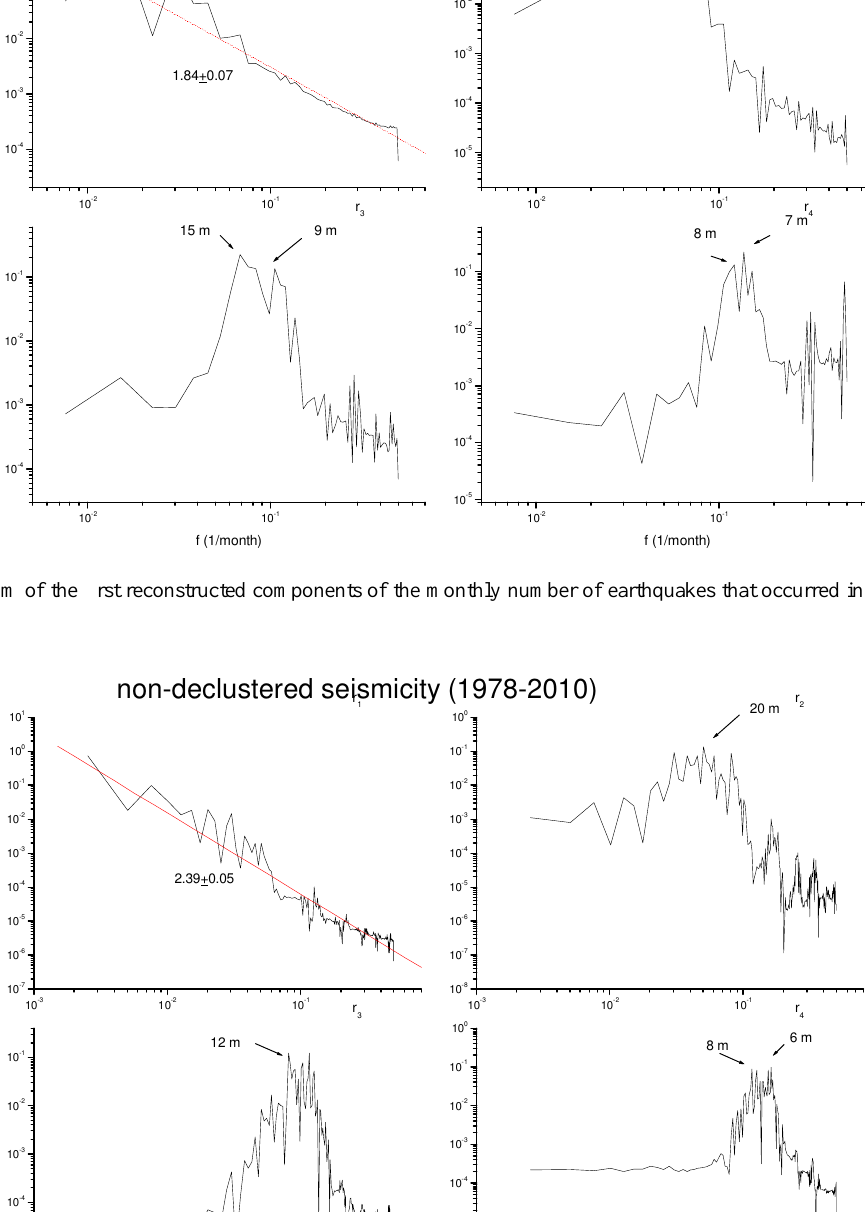
Nat. Hazards Earth Syst. Sci., 12, 2479–2485,